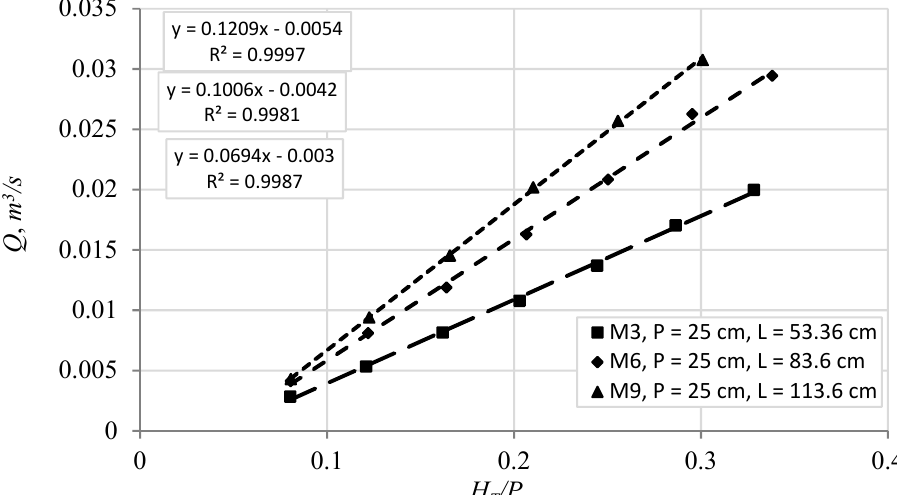
Figure 19. Total discharge, Q, vs. H T /P for models M3, M6, and M9.